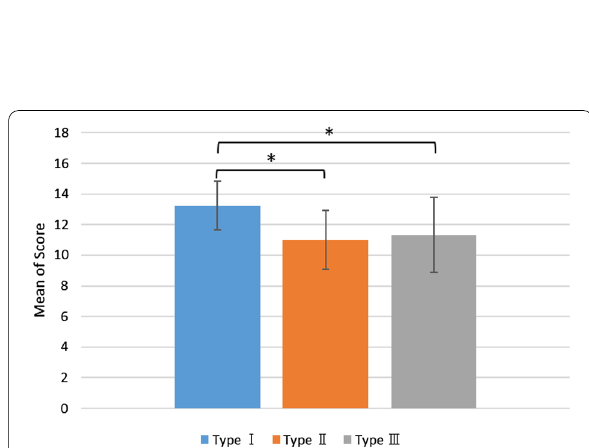
Fig. 15 Means of the score for each type during the attenuation activity (*p <